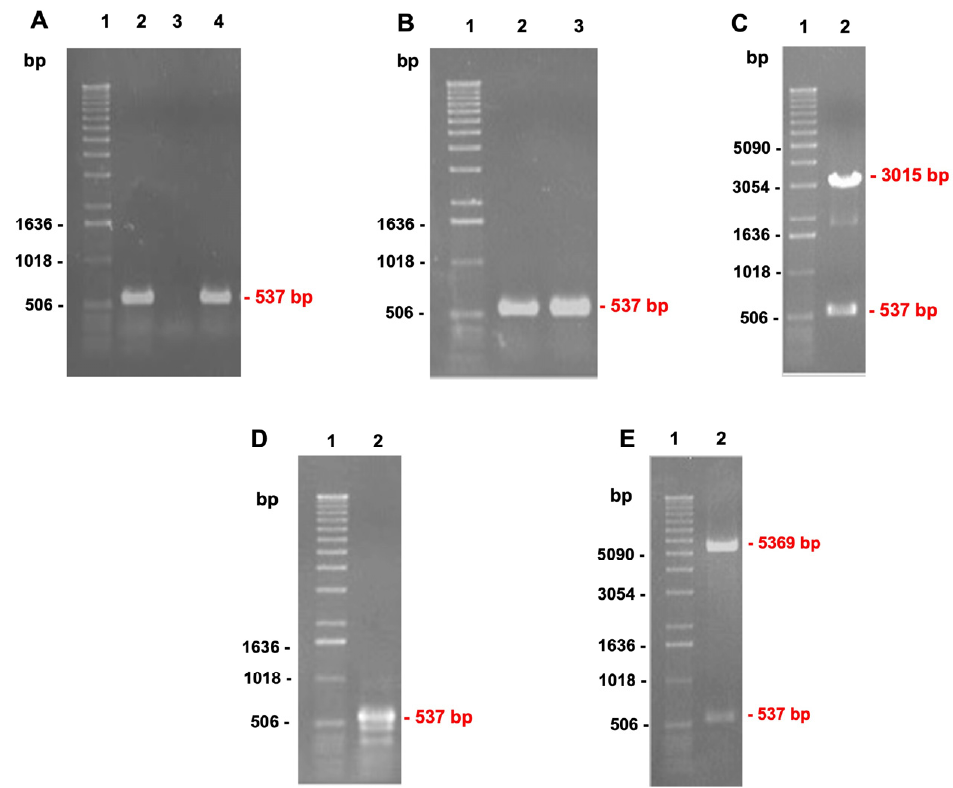
Figure 1. pilS cloning steps from aEPEC BA558 strain. Electrophoretic profile in 0.8% agarose gel stained with UniSafe Dye (Uniscience) and visualized on a transilluminator under UV light. ( A ) Amplified fragments after PCR reactions for detection of pilS gene in aEPEC BA558 strain: 1. 1 Kb DNA ladder (Invitrogen); 2. EAEC C1096: positive control; 3. E. coli C600: negative control; 4. aEPEC BA558 strain; ( B ) Amplified fragments after PCR reactions for pilS cloning confirmation in pGEM-T Easy: 1. 1 Kb DNA ladder (Invitrogen); 2. EAEC C1096: positive control; 3. aEPEC BA558